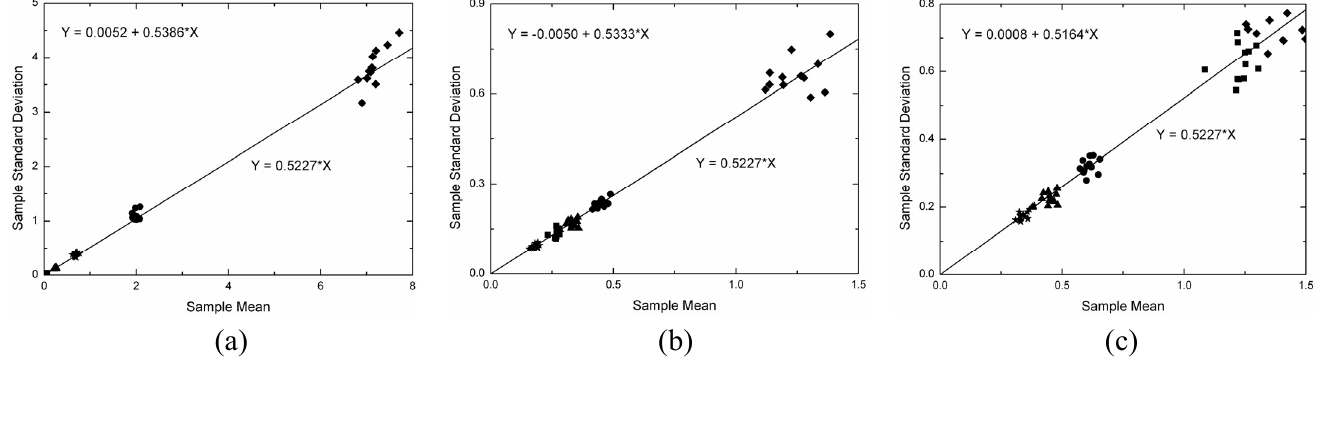
Table 4. Statistic for the regression linear